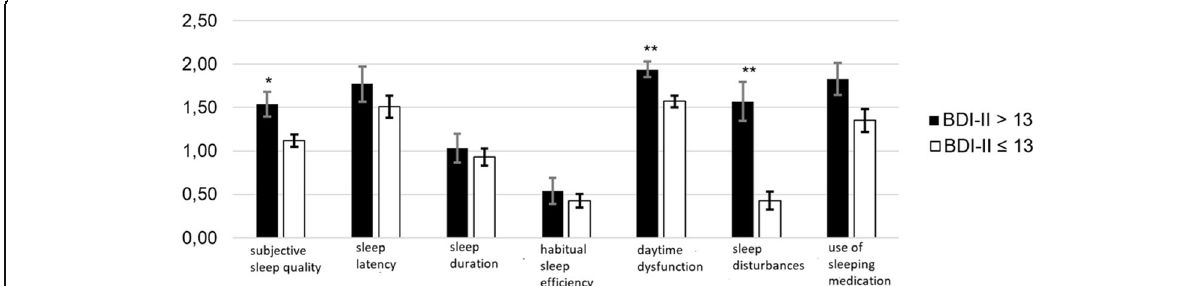
Fig. 1 Pittsburgh Sleep Quality Index components subjective sleep quality, sleep disturbances, use of sleep medication and daytime dysfunction were significantly impaired in RA patients with depressive symptoms as compared to those without depressive symptoms. Definition of